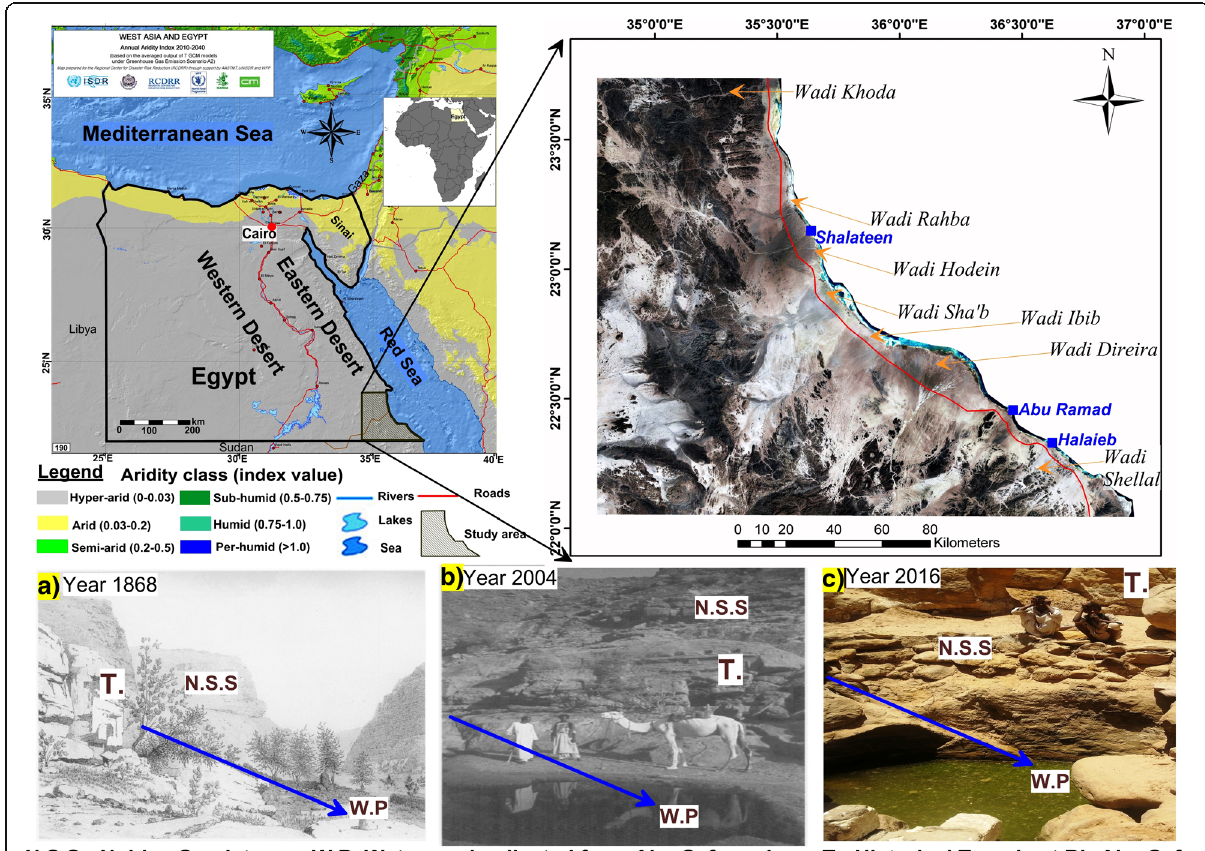
Fig. 1 Location map of the study area is illustrated on an aridity map of ICARDA (2010) where the area is falling in the hyper-arid zone. The main basins were elucidated through Landsat image (LC8). Three photos ( a , b , c ) clarify the continuous supply of freshwater from Nubian Sandstone Aquifer since 1868 until present. ( a ) Photo for the year 1868 was drawn by a French explorer (Linant de Bellefonds) (Sidebotham et al.